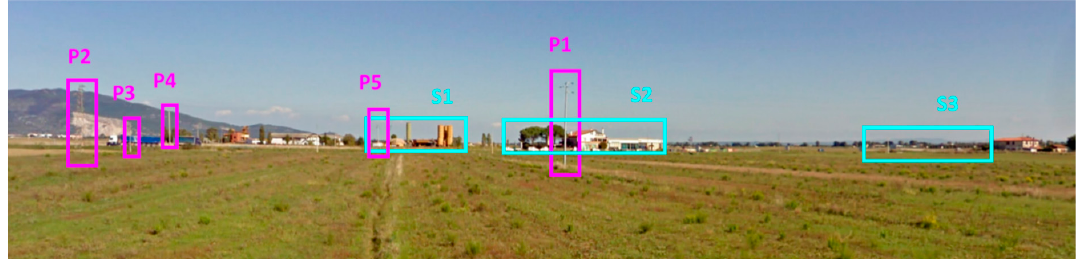
Figure 10. Acquisition scenario, SPARX point of view.